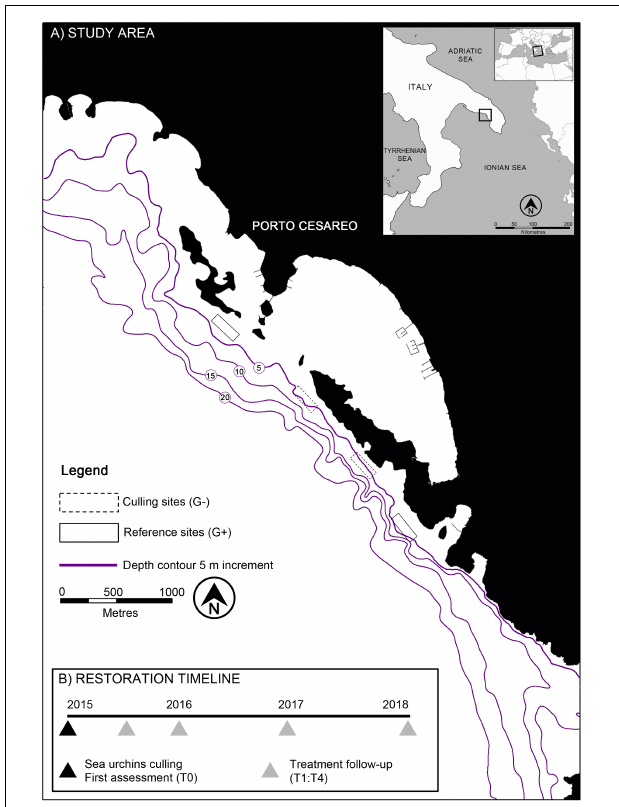
FIGURE 1 | (A) Study area and (B) timeline of the restoration